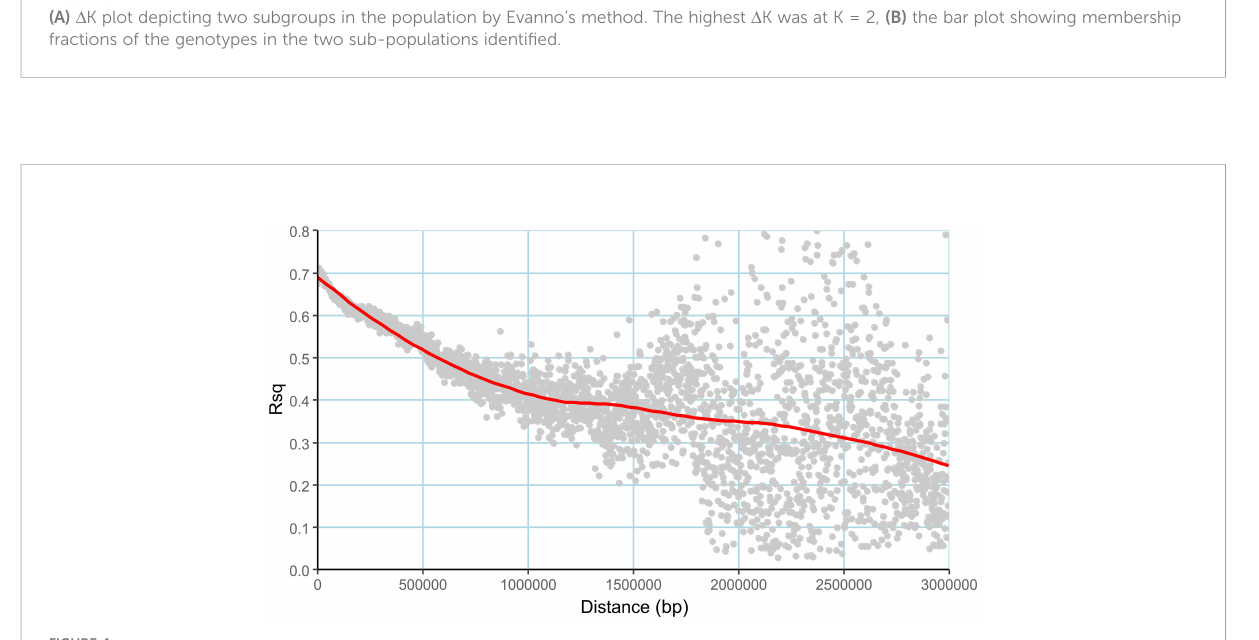
(Table 7). Allelic combinations of three stable MTAs of PHT revealed fi ve unique allelic combinations (Supplementary